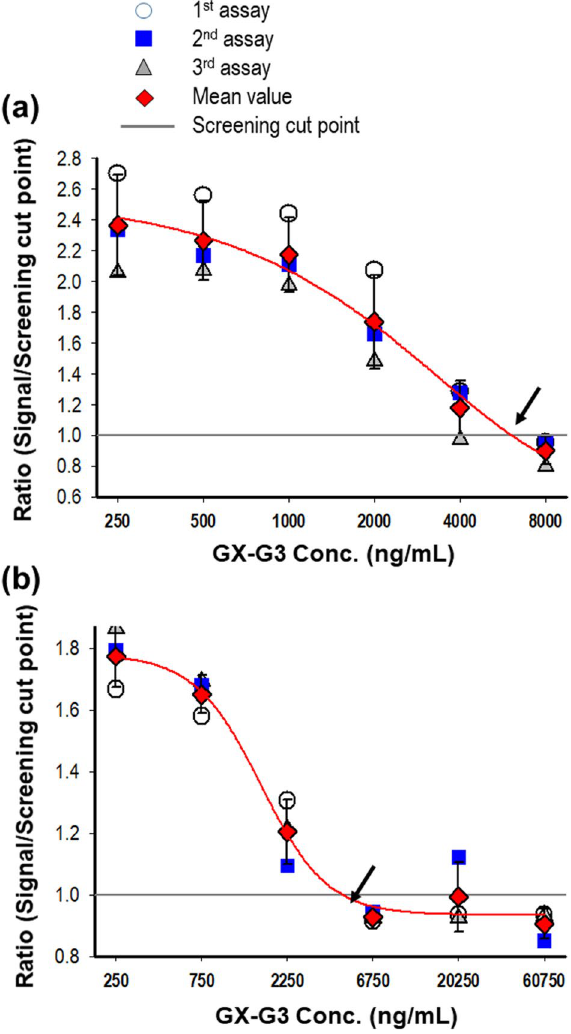
Figure 5. Estimation of drug interference. Low-concentration PC were pre-incubated with serial dilutions of the drug GX-G3 for 1 h. ( a ) Low-concentration PC in pooled rat sera were pre-incubated with the drug GX-G3 at a concentration ranging from 250 to 8000 ng/mL. ( b ) Low-concentration PC in pooled monkey sera were pre- incubated with the drug GX-G3 at a concentration ranging from 250 to 60750 ng/mL. The highest concentration of drug at which the absorbance value was equal to the normalized NCO value is shown in the